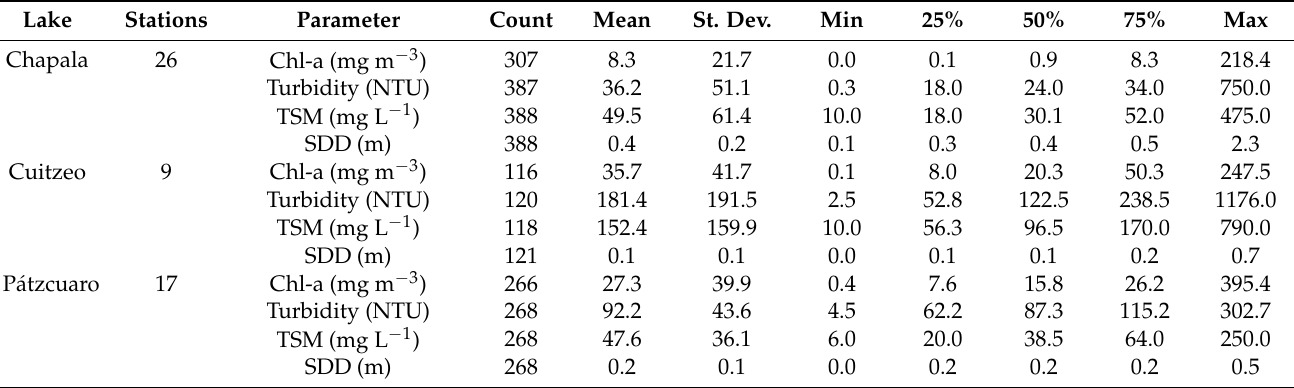
Figure A1. In-situ and S3 derived water quality parameters vs. field data from RNMCA by lake. The upper row shows the Chl-a comparison, the lower row shows TSM. Table A1. Descriptive statistics of the RNMCA dataset.